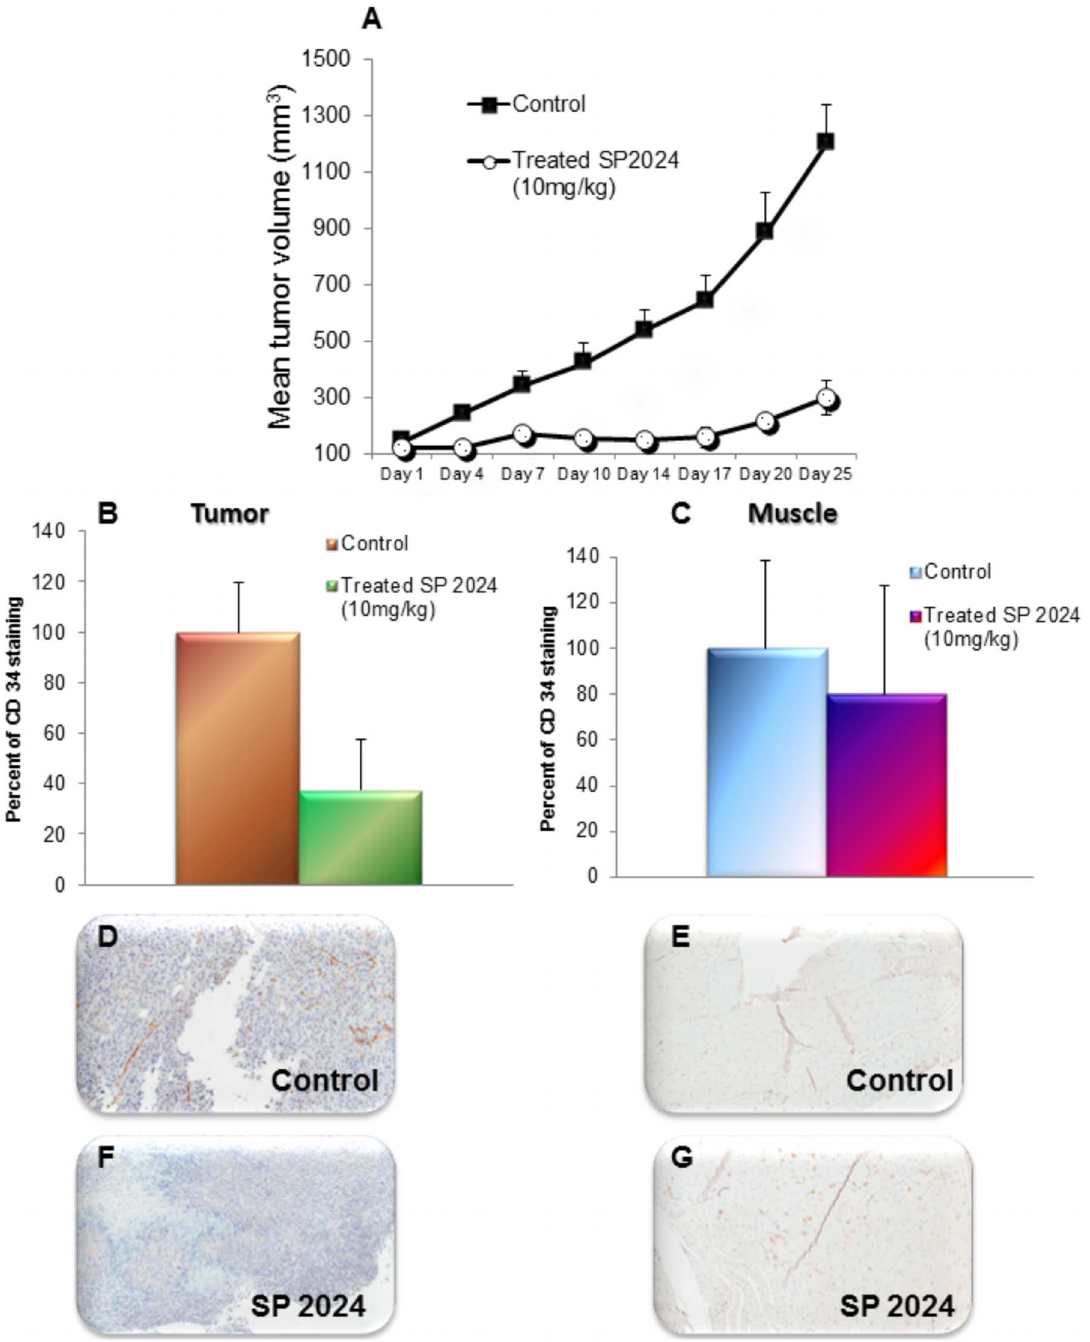
Figure 5. Tumor growth inhibition and effects on the density of microvascular density. Inhibition of growth of MDA-MB-231 orthotopic xenografts as a result of peptide treatment. When tumors reached a volume of approximately 100 mm 3 treatment commenced with daily i.p. injections of 10 mg/kg SP2024. Tumor size was monitored by calipers every fourth day. Statistical significance (p , 0.001) between the treated and control groups was observed starting (A) with Day 7 measurement and continued until the termination of the study (Day 27). (B and C) Quantification of microvascular density in sections stained by IHC of tumors and muscles using CD34 antibodies showing significant differences (p , 0.001) in the tumors but no significant difference in muscle (p=0.093), illustrating the specificity of the peptide to neovasculature. (D, E, F, and G) Representative images of tumors and muscles from the control and treated groups. doi:10.1371/journal.pone.0111901.g005 assessed the level of apoptosis in the excised tumor sections by the treatment resulted in a 60% increase of caspase-3 activity in the treated tumor sections compared to the control ones. This caspase-3 staining. We observed a significant increase in caspase-3 activity in the SP2024 treated group compared to the control result was indicative of an increased apoptotic phenotype due to group. Figure 7 shows the caspase-3 staining and quantification;